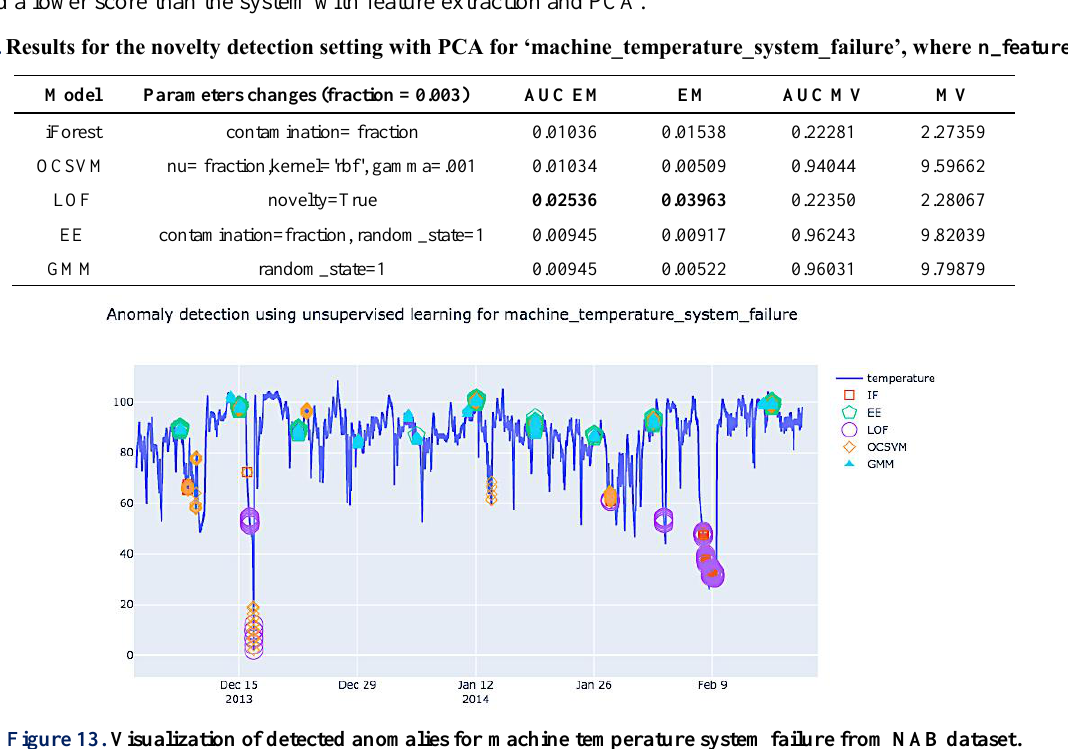
Figure 13. Visualization of detected anomalies for machine temperature system failure from NAB